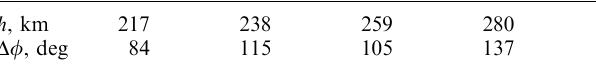
Table 4. Angle between TID group and phase velocities h , km